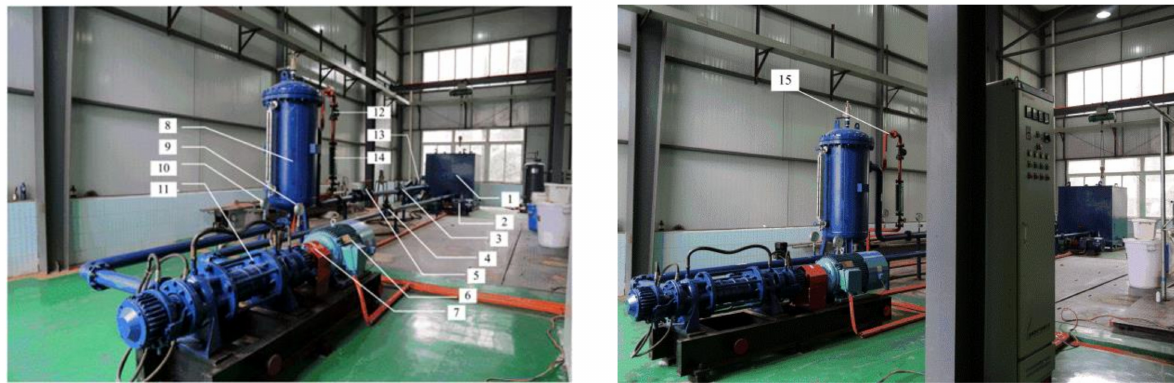
Figure 2. The multiphase pump test system. 1. Water tank; 2. Water supply pump; 3. Flow meter; 4. Outlet valve; 5. Inlet valve; 6. The motor; 7. Torque meter; 8. Gas-liquid mixing tank; 9. Outlet pressure gauge; 10. Inlet pressure gauge; 11. Multiphase pump; 12. Check valve; 13. Air compressor; 14. Gas flow meter; 15. Gas